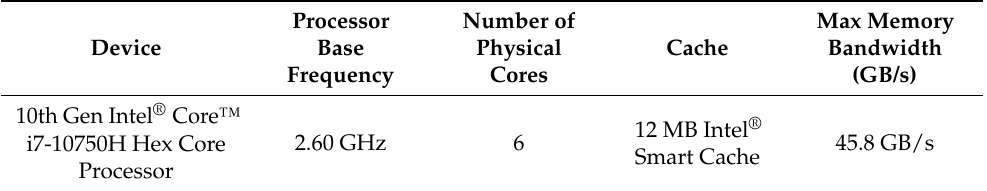
Table 1. The hardware details of the experimental